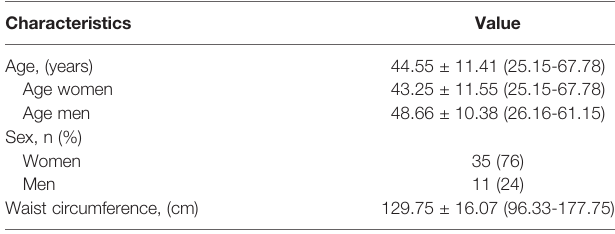
TABLE 1 | Baseline Characteristics of participants (n =